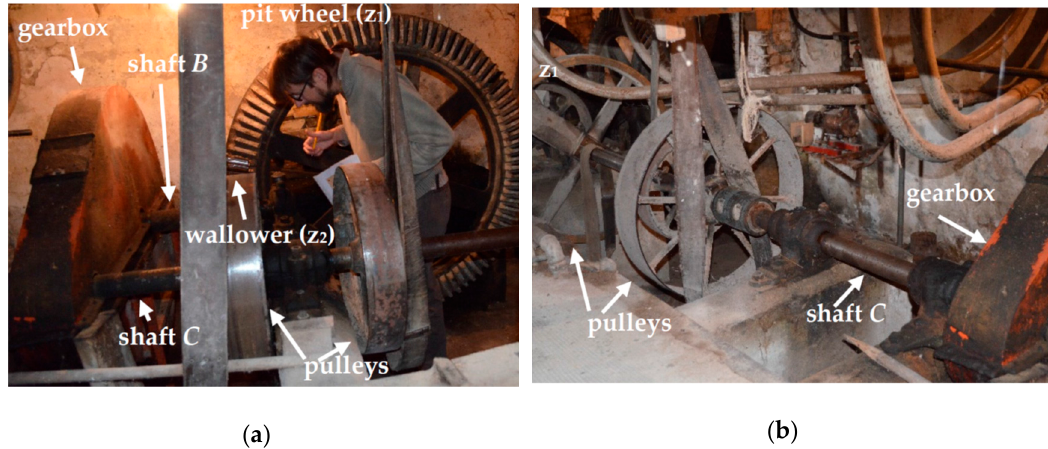
Figure 13. The Forno mill downstream water wheel power transmission: ( a ) The first bevel gear multiplier and the spur gearbox; ( b ) the pulleys actuating the roller mills.